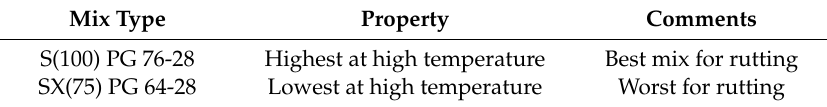
Table 2. Summary of the most durable and worst mixes for